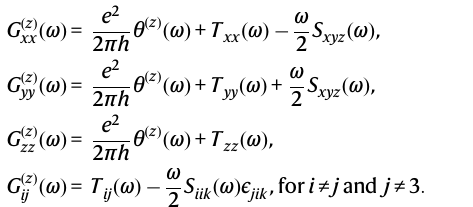
Fig. 1 | Optical magneto-electric effect. Magneto-electric (ME) coupling leads to different electrodynamics within the bulk and on the surface. Inside the magneto- electric medium, two linearly polarized light propagate with different speeds because the wave equation is modi fi ed by origin-independent magneto-electric coupling T ij and electric quadrupole susceptibility S ijk (this effect is called gyro- tropic birefringence 20 ). On the surface, axion magneto-electric coupling θ ( z ) comes into play additionally, contributing to the surface Hall conductivity. This is most readily seen by writing the action for optical axion electrodynamics allowing for a